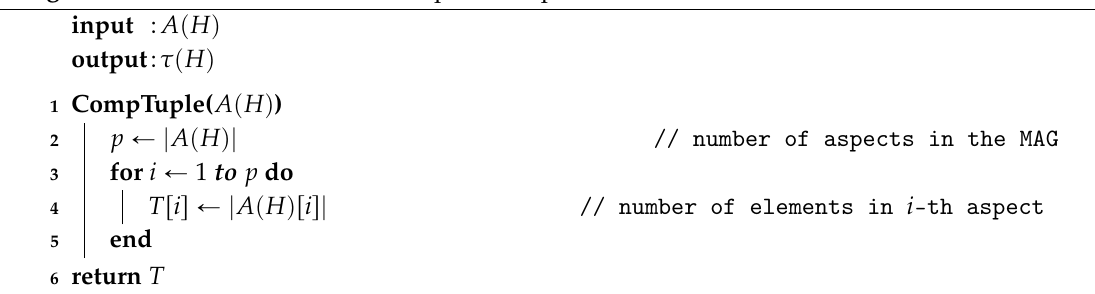
Algorithm 1: Construction of the companion tuple of a MAG.